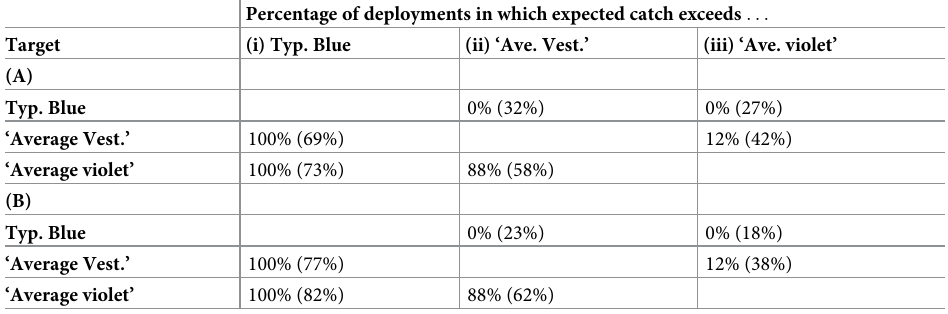
and contributes to the discrepancy in findings versus those for savannah species [10]. We sug- gest that this high variability may be a feature of Tiny Target deployments against riverine spe- cies, since those species are less discriminating than savannah tsetse over targets as indicated by their relative indifference to target size [14]. This may be because riverine tsetse are less dis- criminating over potential hosts due to the way in which their search behaviour is constrained Table 11. Future target performance estimated by analysis of new data collected in Uganda, incorporating priors from the analysis of data collected in Kenya that itself used informative priors. Predictions are displayed for (A) over-dispersed Poisson, and (B) zero-inflated over-dispersed Poisson models. Percentage of deployments in which expected catch exceeds ... Target